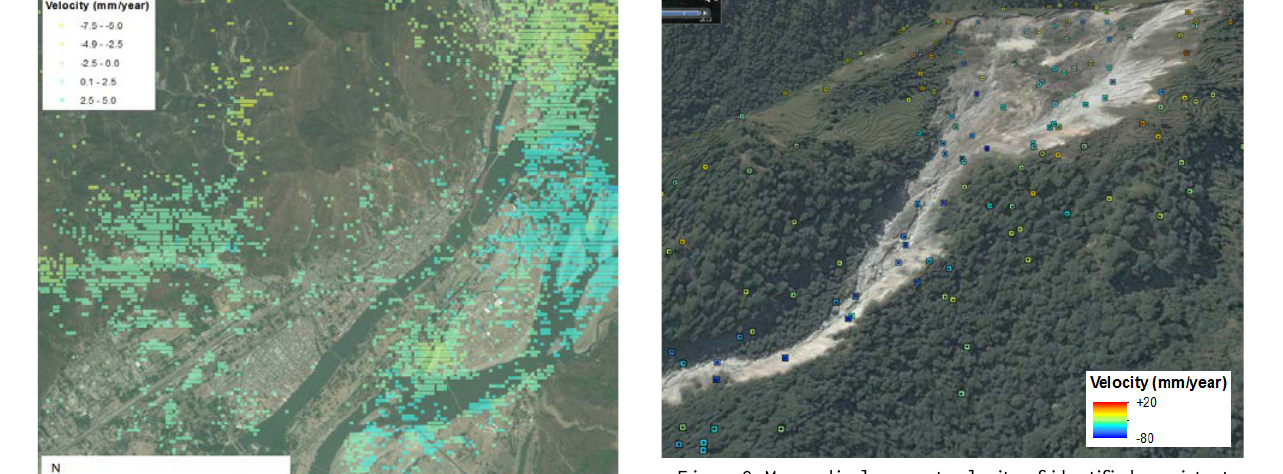
Figure 9: Mean displacement velocity of identified persistent scatterers in LOS direction (in mm/year) superimposed on a Figure 8: Mean velocity map for the Mansa Devi hill area (and GoogleEarth image. Note the inversed colour scale as compared the town of Haridwar) using the EnviSAT Track 291 image to Figures stack processed with SARscape's SBAS workflow. Background data: Esri, DigitalGlobe, GeoEye, i-cubed, USDA, USGS, AEX, Getmapping, Aerogrid, IGN, IGP, swisstopo and the GIS User Community.